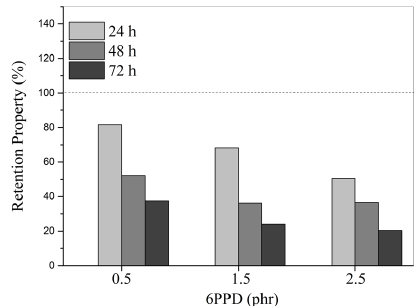
Figure 4. Retention of tensile strength at thermal-oxidative aging in oven comprising 0.5 phr of TMQ in combination with different 6PPD contents.